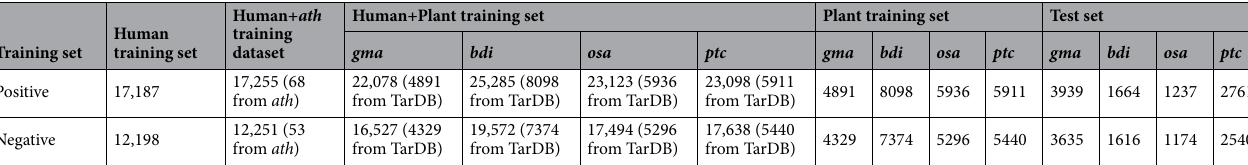
Table 2. The composition of the training sets and test sets used to train four classifiers (Human, Human+ath, Human+Plant, and Plant) for application on four test sets ( Glycine max , Oryza sativa , Populus trichocarpa , and Brachypodium distachyon